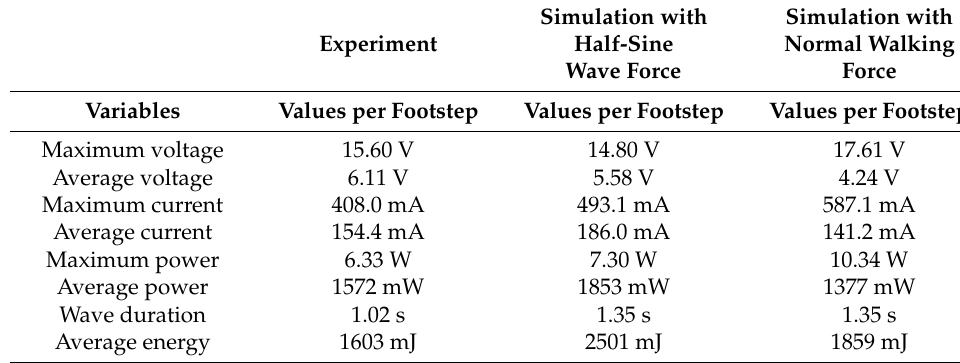
Figure 4. Voltage, current, power, and energy of the Genpath V2 from experiment and simulation: ( a ) voltage and current of the Genpath V2. ( b ) power, and energy of the Genpath V2. Table 2. Performances of the Genpath V2 when K = 18,000 N/m. Simulation with Experiment Half-Sine Wave Normal Walking Force